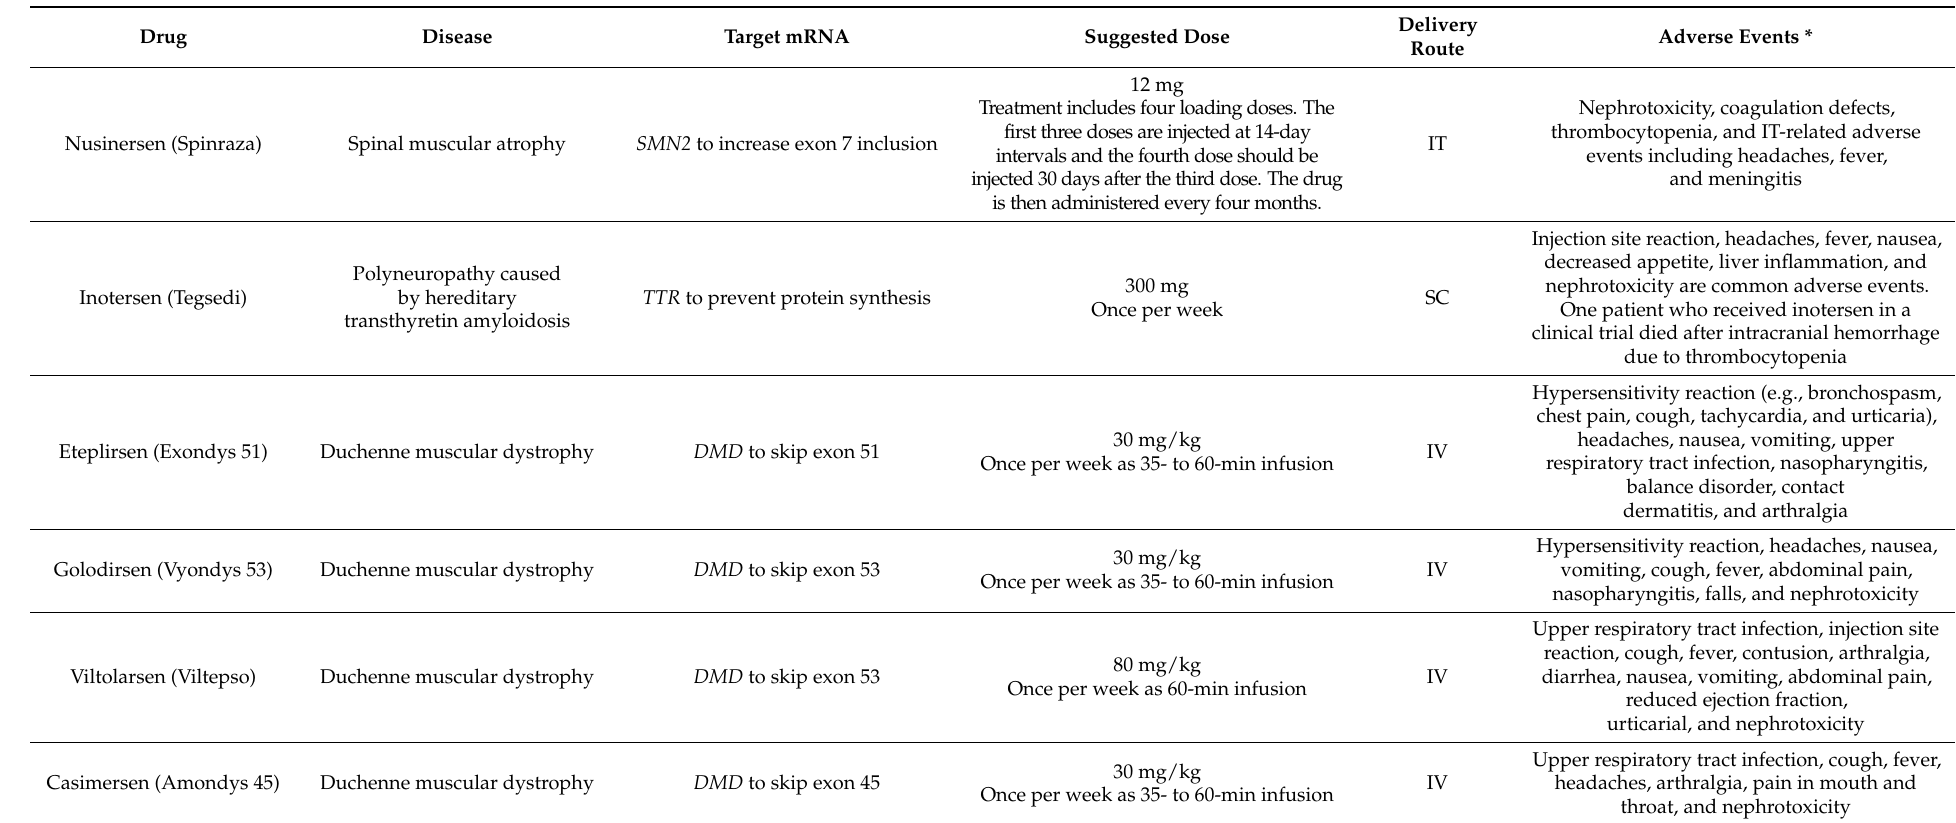
Table 2. FDA-approved antisense oligonucleotides in neurological